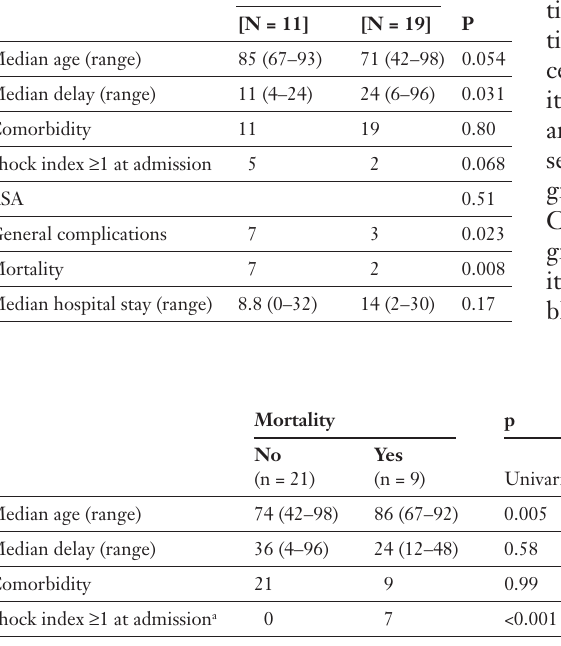
Patients’ clinical features according to type of antisecretory therapy.